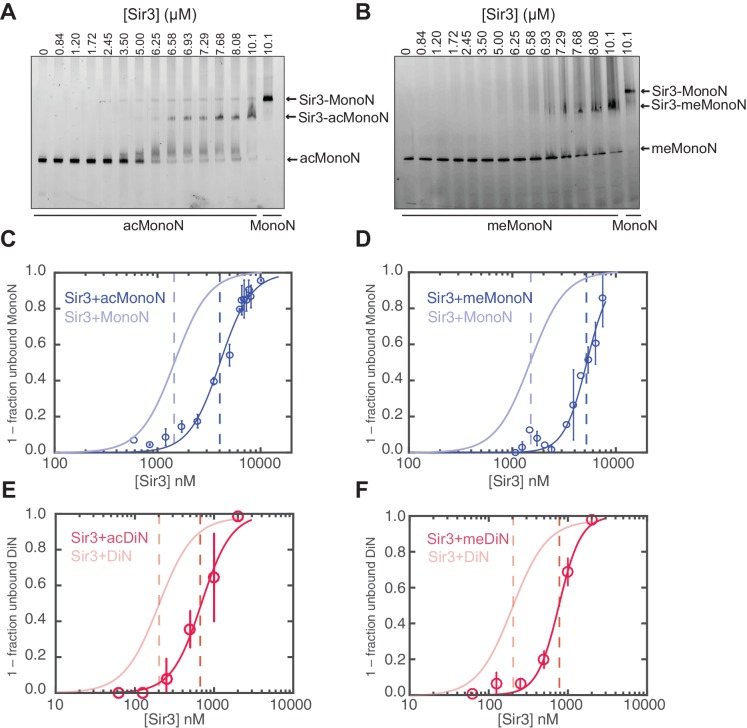
H4K16 acetylation and H3K79 methylation act together to strongly inhibit the binding of Sir3 to nucleosomes.(A, B) Comparison of Sir3 binding to unmodified and H4K16ac MonoN (A), or unmodified and H3KC79me3 MonoN (B) by EMSA. We note that Sir3 bound H4K16ac and H3KC79me3 MonoN and DiN shift to a lower position than Sir3 bound unmodified nucleosomes, suggesting that Sir3 binds to modified nucleosomes in a different conformation than to unmodified nucleosomes. (C) Binding curves from three experiments performed as in (A) were fitted with the Hill Equation. (D) Binding curves from three experiments performed as in (B) were fitted with the Hill Equation. (E) Comparison of Sir3 binding to unmodified and H4K16ac DiN. Binding curves from three experiments performed as in Figure 5—figure supplement 2A were fitted with the Hill Equation. (F) Comparison of Sir3 binding to unmodified and H3KC79me3 DiN. Binding curves from three experiments performed as in Figure 5—figure supplement 2B were fitted with the Hill Equation. In C–F, curves in lighter colors show model fits to binding data of unmodified nucleosomes for visual comparison. Data and fits are shown in Figure 1E. Blue and Red dotted lines indicate the apparent KD for Sir3 binding to MonoN and DiN, respectively. See Table 1 for parameter values. Note that the titrations of modified nucleosomes are not fully saturated at the highest concentrations tested and the calculated apparent affinities may be overestimated.